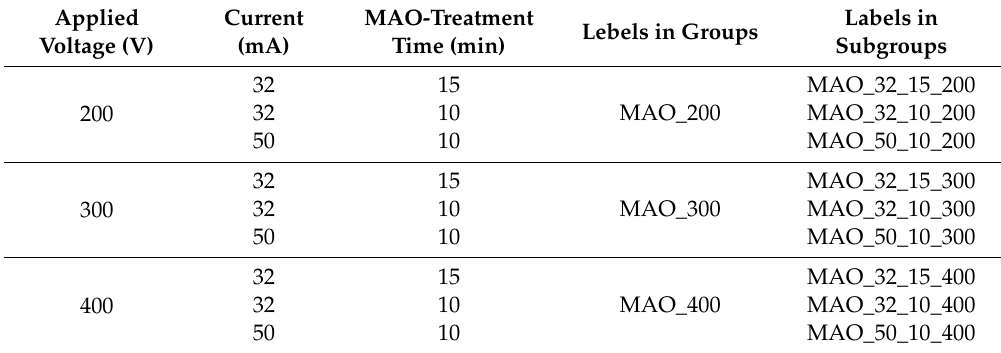
Table 1. The labels of micro-arc oxidation (MAO) coatings formed at di ff erent process